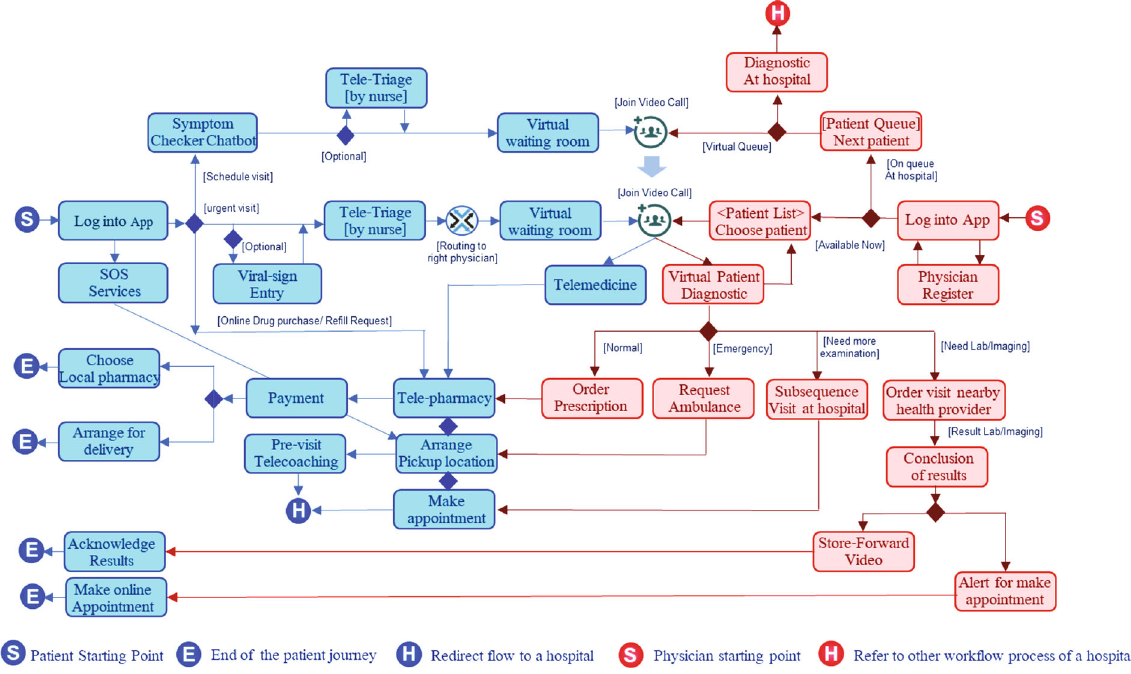
Figure 3: A comprehensive patient journey design of telemedicine